Question: Is the quantity shown trending increasing or decreasing?
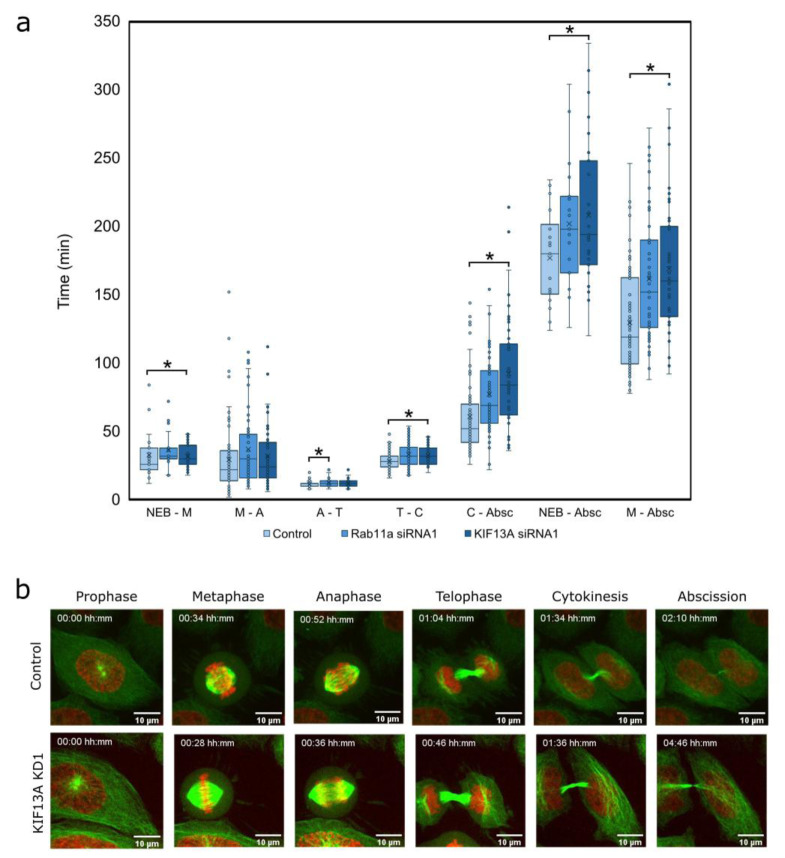
Answer: increasing